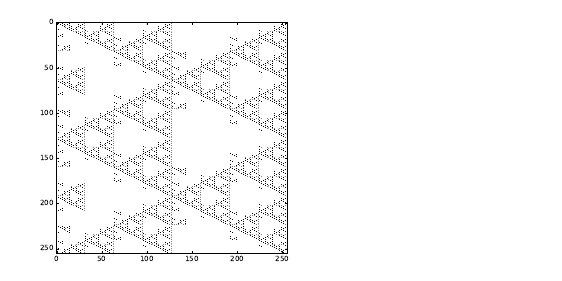
Figure 6: The indicator function of the ddt of η ( x ) = A 3 ( x ) ⊕ x for n =